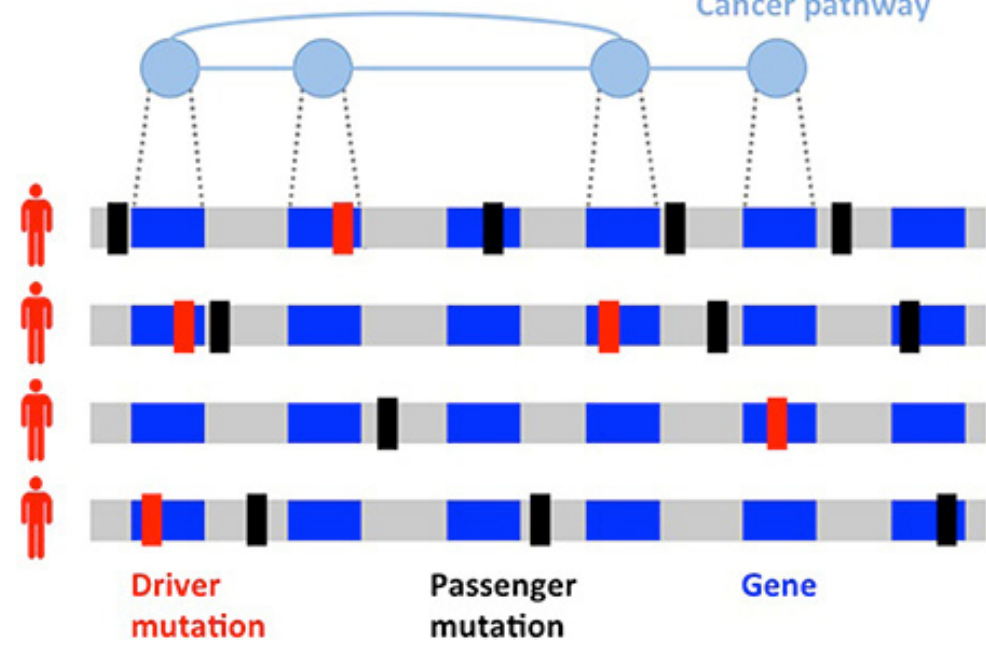
Figure 1. Heterogeneity of cancers. Driver (red) and passenger (black) mutations in the development of a tumor. Driver mutations are much less common than passenger mutations and involve genes implicated in cancer pathways. Figure reproduced with permission by Vandin [21]. http://crea- tivecommons.org/licenses/by/4.0/, accessed on 2 May 2022.